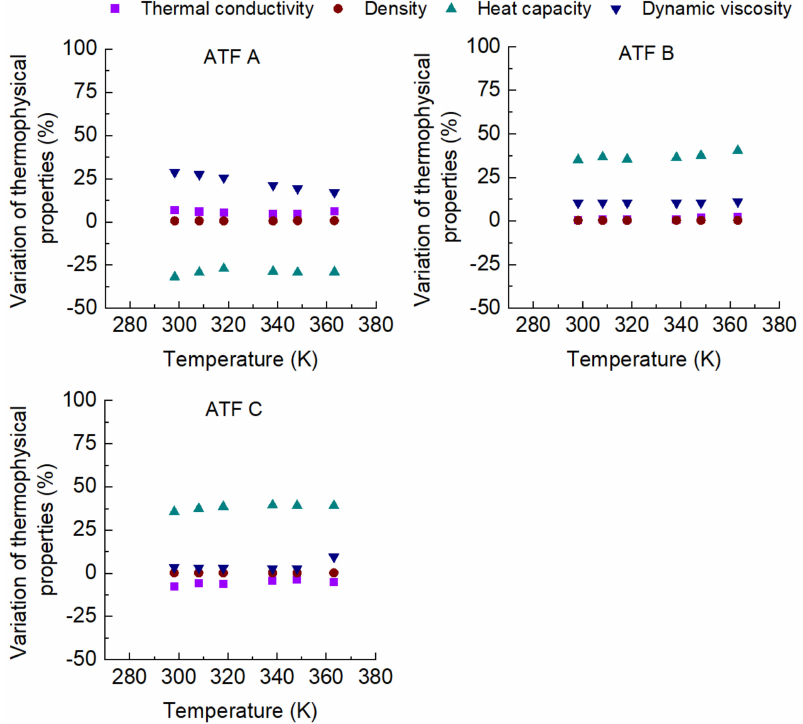
Figure 7. Sensitivity to temperature of the variation of the thermophysical properties with